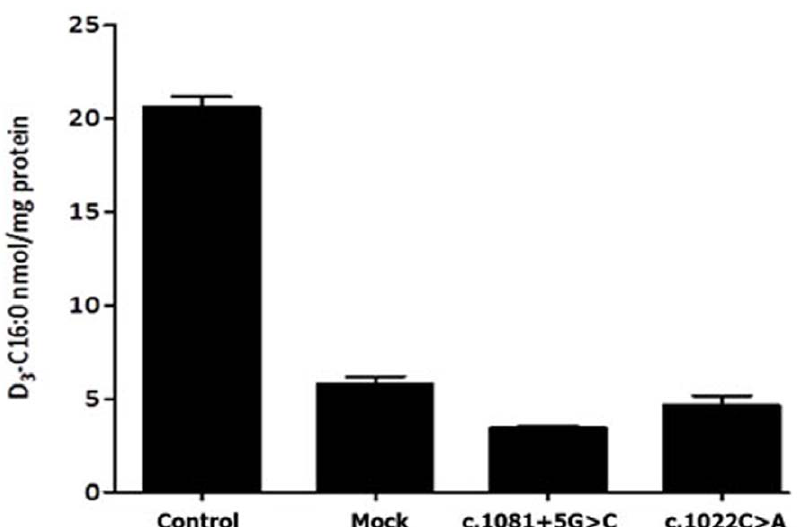
Figure 4. Peroxisomal b -oxidation was measured using stable-isotope labeled VLCFA (modified from Kemp et al., 2004). D3-C16:0 levels in normal, X-ALD (mock) and X-ALD fibroblast from patients; c.1081 + 5G . C and c.1022C . A (p.Ala341Asp).